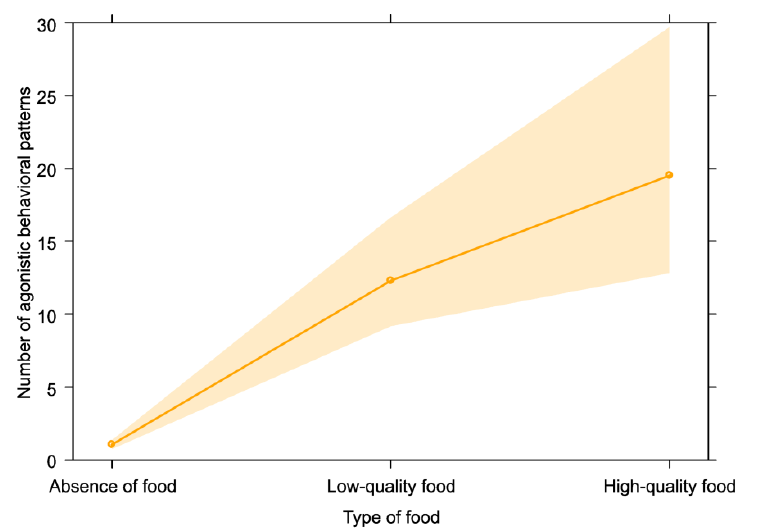
Figure 5. Effect plot of the variable with a significant effect on agonistic behavior. The number of agonistic behavioral patterns (y-axis) was highest in presence of high-quality food (x-axis).